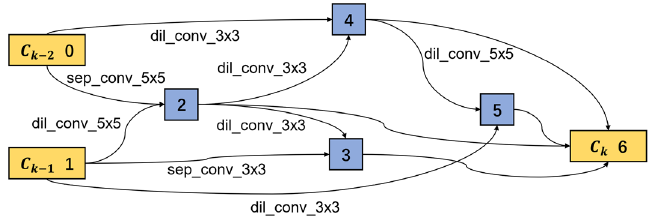
Figure 9. Learned normal cell structure in the search phase.